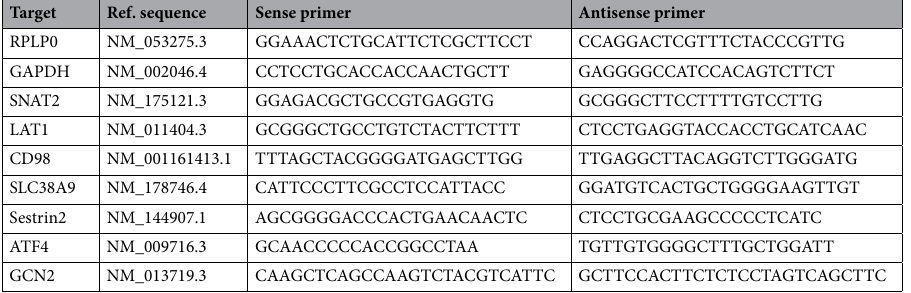
Table 2. Sequences of PCR primers for RPLP0, GAPDH, SNAT2, LAT1, CD98, SLC38A9, Sestrin2, ATF4, and GCN2